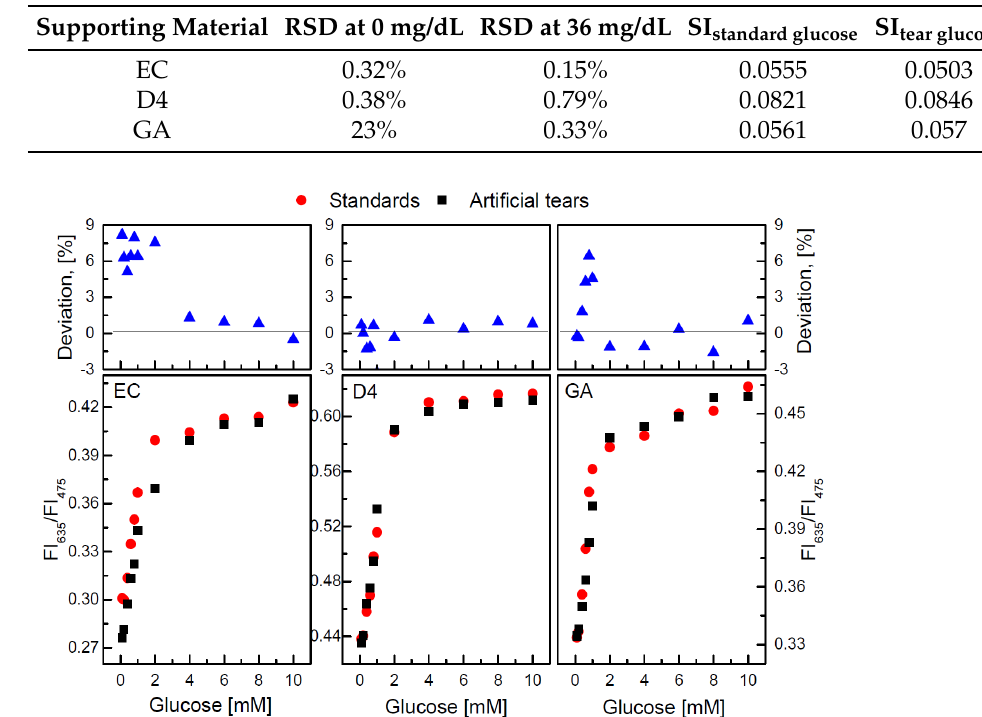
Figure 4. Percentage deviation of radiometric fluorescence intensities and the response between radiometric fluorescence intensities and standard and tear glucose (Reprinted from Ref.